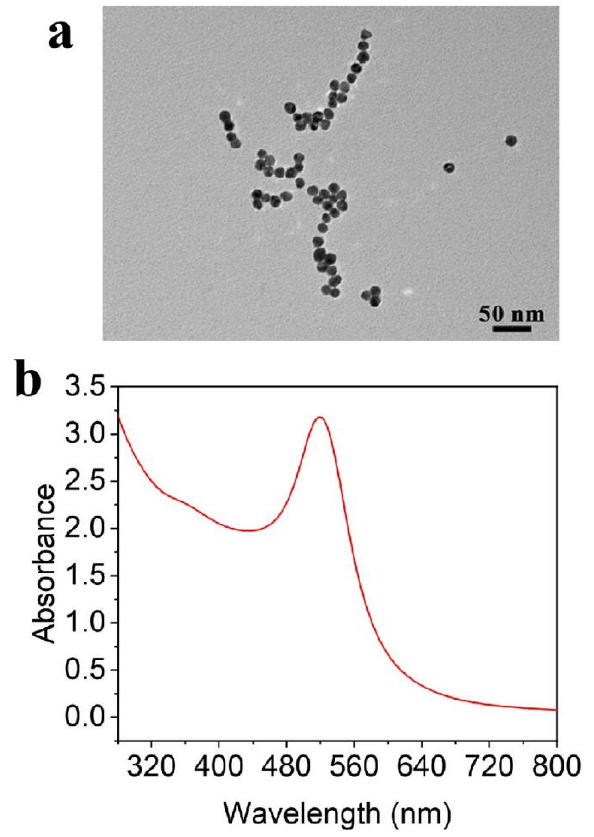
Figure 1. TEM image ( a ) and UV − vis absorption spectrum ( b ) of the synthesized AuNPs.